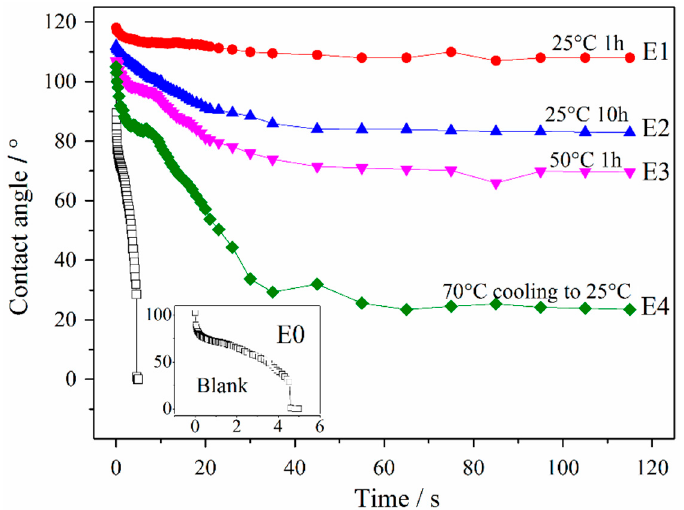
Figure 11. The dynamic contact angle of the sizing-treated paper fabric with different emulsions.